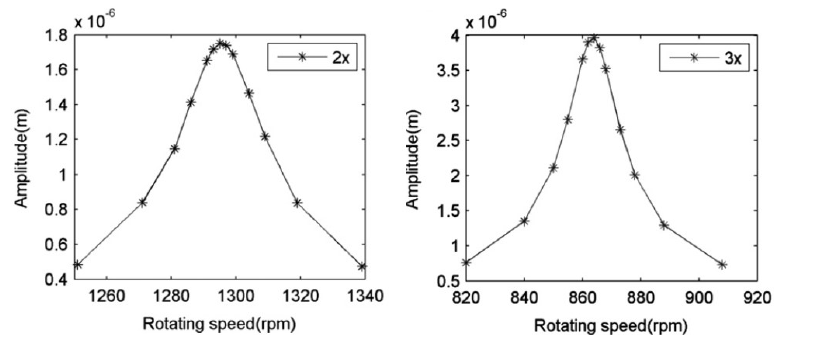
Figure 15. Amplitudes of 2 X and 3 X at speeds close to p = 1 Reprinted/adapted with permission from [45]. 2013.